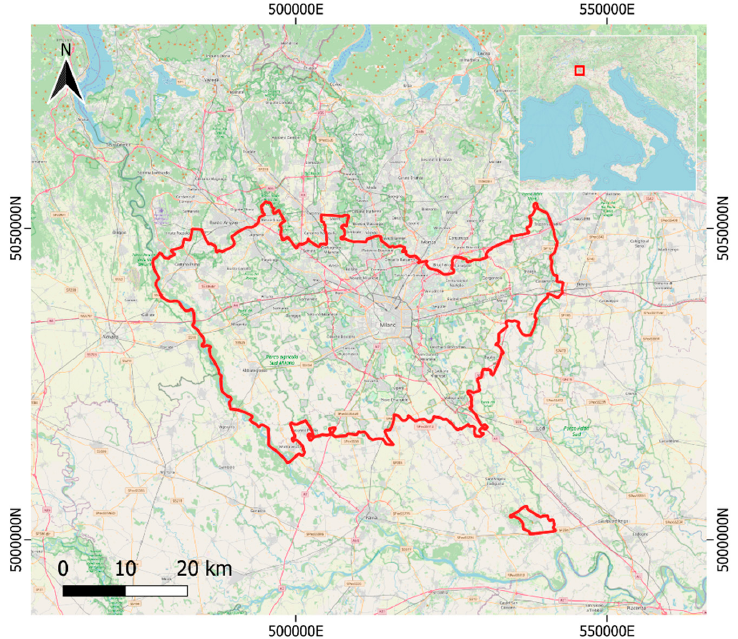
Figure 1. Location of the study area (Metropolitan City of Milan, northern Italy). Coordinate Reference System (CRS): WGS84/UTM zone 32N. Basemap data: © OpenStreetMap